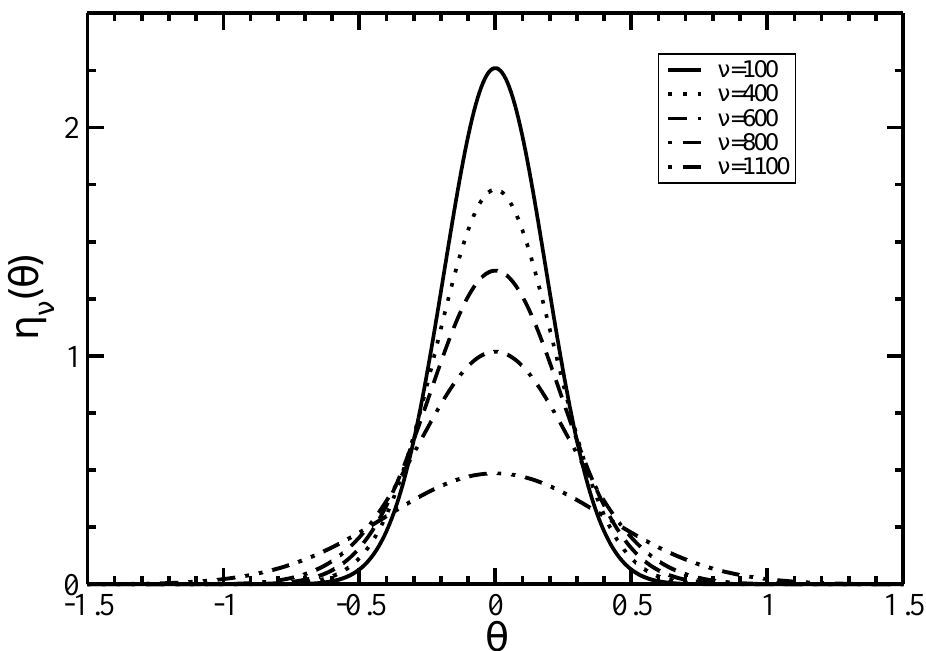
Figure 5. The angular distribution function η ν ( θ ) as a function of the angle θ at the I–N phase coexistence for different sizes ν . The average length is < ν > =